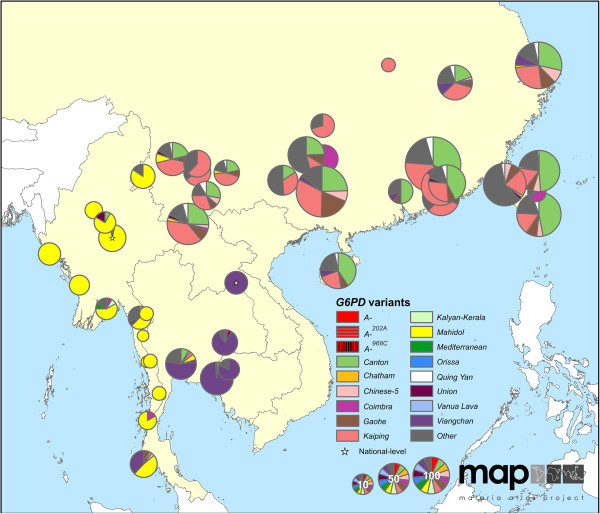
G6PDd variant proportion map: East Asia (map series 1). A higher resolution map of Figure 
4.